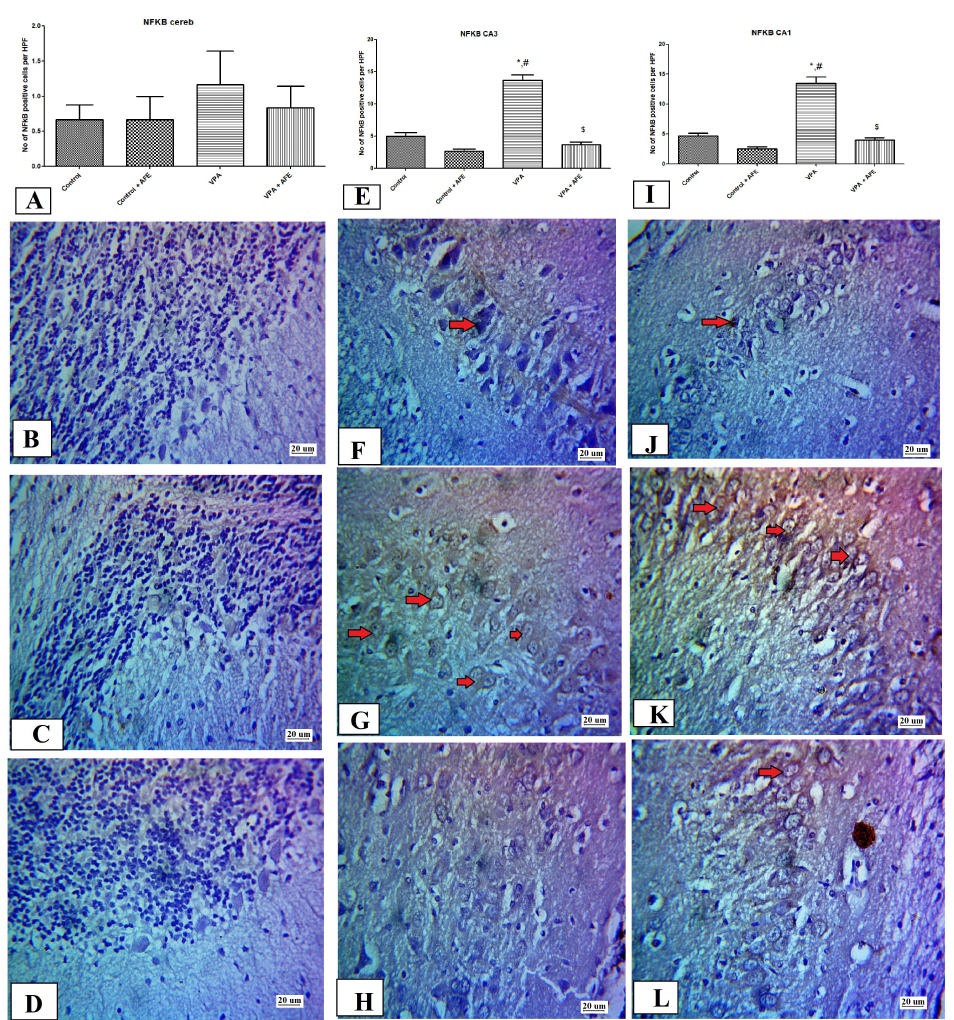
Figure 8. Effect of AFE on the NF κ B expression in the cerebellum and hippocampus. ( A , E , I ) show the mean number of NF κ B positive cells in the Purkinje cells (PC) layer of the cerebellar cortex, CA3 hippocampal region, and CA1 hippocampal region of different groups, respectively. ( B – D ) show negative nuclear and cytoplasmic expression of NF κ B in the PC of the cerebellar cortex of the control, VPA group, and VPA + AFE group, respectively. ( F – H ) show positive nuclear expression (red arrows) of NF κ B in CA3 of the control group (minimal), VPA group (mild–moderate), and VPA + AFE groups (minimal), respectively. ( J – L ) show nuclear expression of NF κ B in CA1 of the control group and VPA group, and VPA + AFE groups, respectively (400 × ). * significant vs. control group, # significant vs. control + AFE group, and $ significant vs. VPA